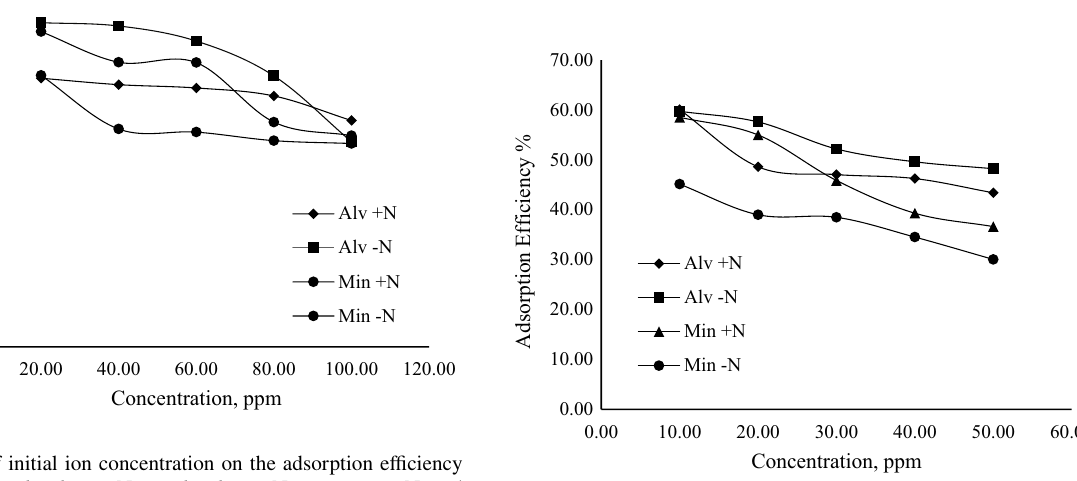
Fig. 4 Effect of initial ion concentration on the adsorption efficiency of Cu 2+ onto N. alveolaris + N, N. alveolaris –N, N. minuta + N, and N/ minuta –N